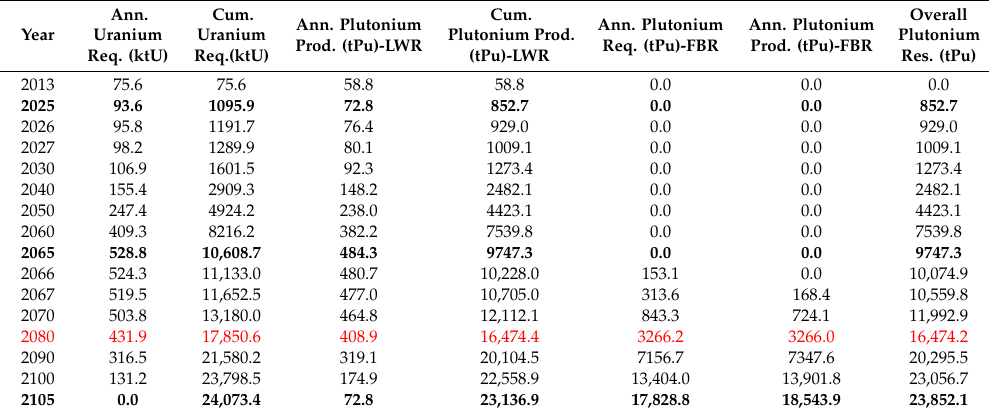
Table 3. Uranium requirements and plutonium production and requirements for scenario S1, sub scenario